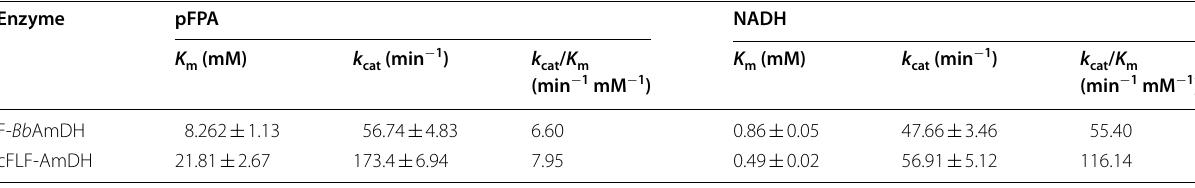
Table 5 Kinetic parameters of the F- Bb AmDH and cFLF-AmDH